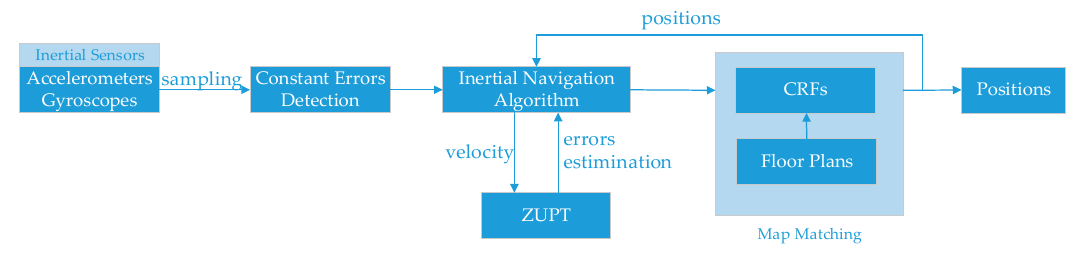
Figure 1. System architecture.